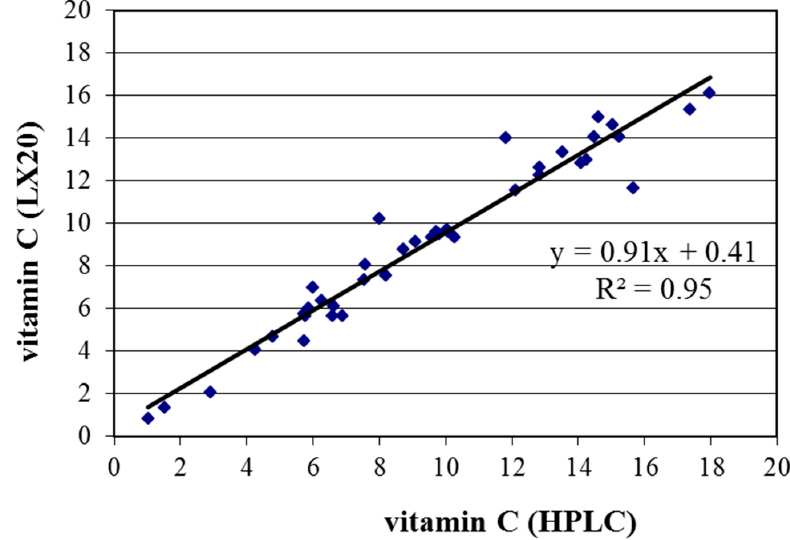
Figure 4. Comparison of the vitamin C determination with HPLC and with a colorimetric method as measured on an auto-analyzer (LX20, Beckman-Coulter, Woerden, The Netherlands).